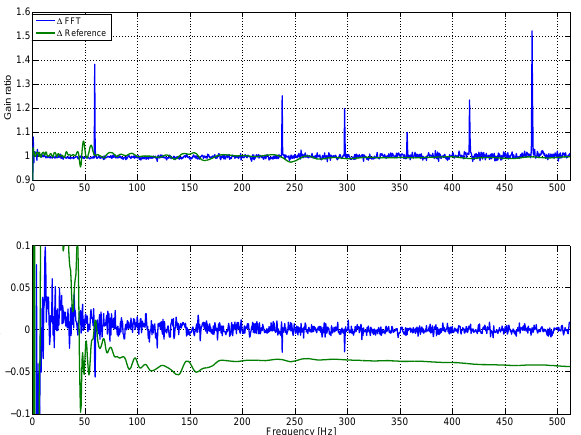
Figure 6. Gain ratio and delay difference between SCM frequency response model and FFT estimate as well as analog reference cali- bration.